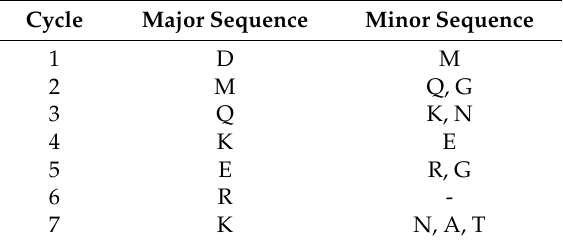
Table 2. N-terminal sequencing result of mature rHZ lipase after auto-removal of the